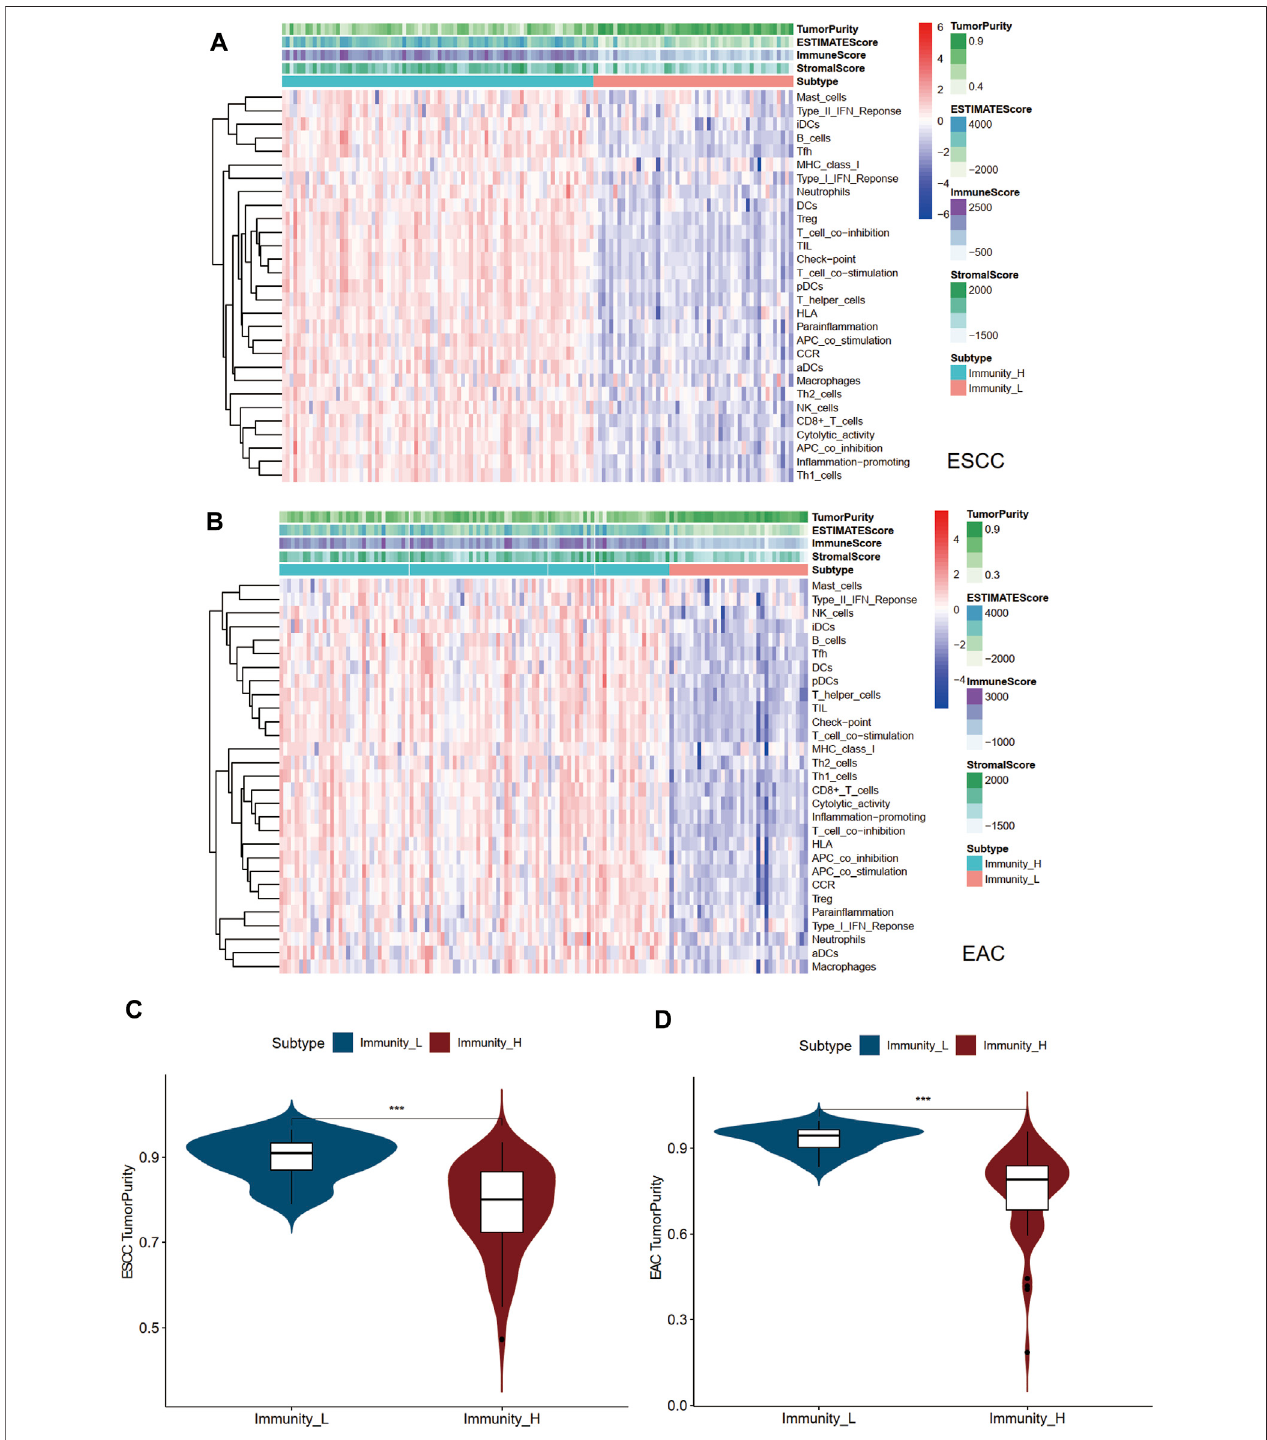
FIGURE 1 | Landscape of tumor immune microenvironment in ESCC and EAC. (A) Heatmap of the tumor purity, ESTIMATE scores, stromal scores, immune scores,andtumor-in fi ltratinglymphocytesinImmunity_LandImmunity_HgroupsinESCC. (B) Heatmapofthetumorpurity,ESTIMATEscores,stromalscores,immune scores,and tumor-in fi ltratinglymphocytesinImmunity_L andImmunity_H groupsin EAC. (C) Difference oftumor purity betweenImmunity_Land Immunity_H groups in ESCC. (D) Difference of tumor purity between Immunity_L and Immunity_H groups in EAC. ESCC, esophageal squamous cell carcinoma; EAC, esophageal adenocarcinoma; ssGSEA, single sample Gene Set Enrichment Analysis; ESTIMATE, Estimation of STromal and Immune cells in MAlignant Tumor tissues using Expression. * p < 0.05; ** p < 0.01; *** p < 0.001.